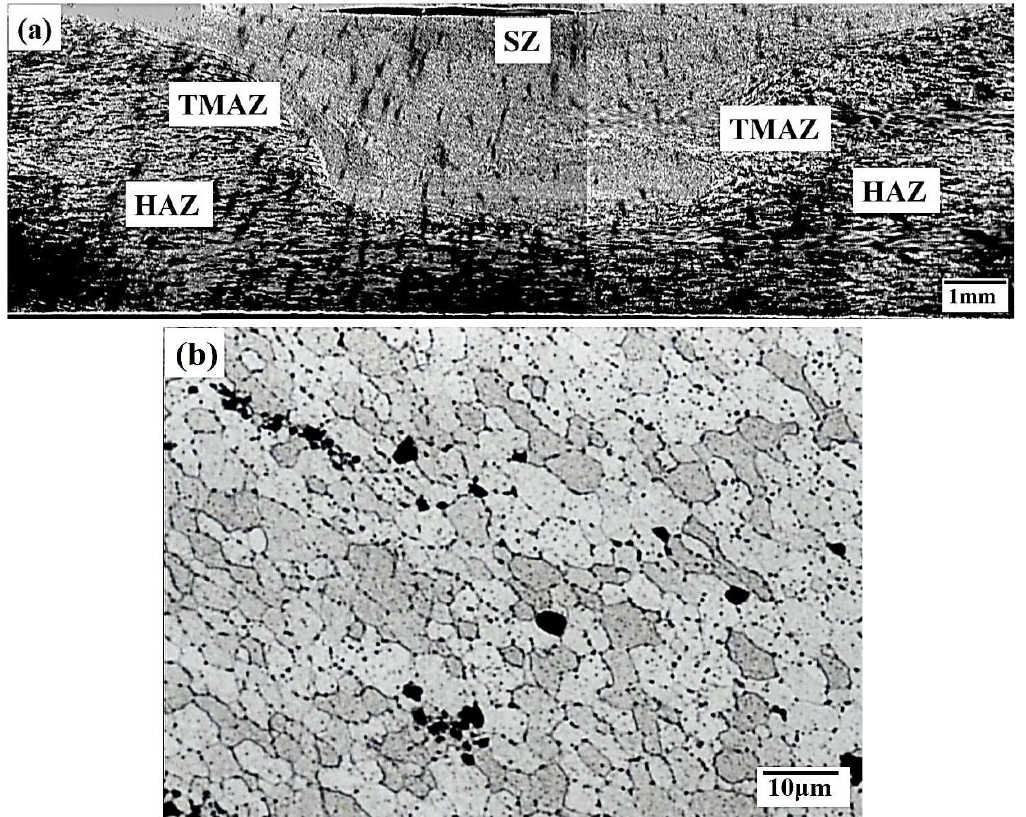
Figure 5. Cross-section of the PD plane for specimens processed at 1450 rpm: ( a ) microstructural zone formation; and ( b ) average grain size of 5.1 μm in the SZ. (SZ: stir zone; TMAZ: thermo mechanically affected zone; HAZ: heat affected zone)